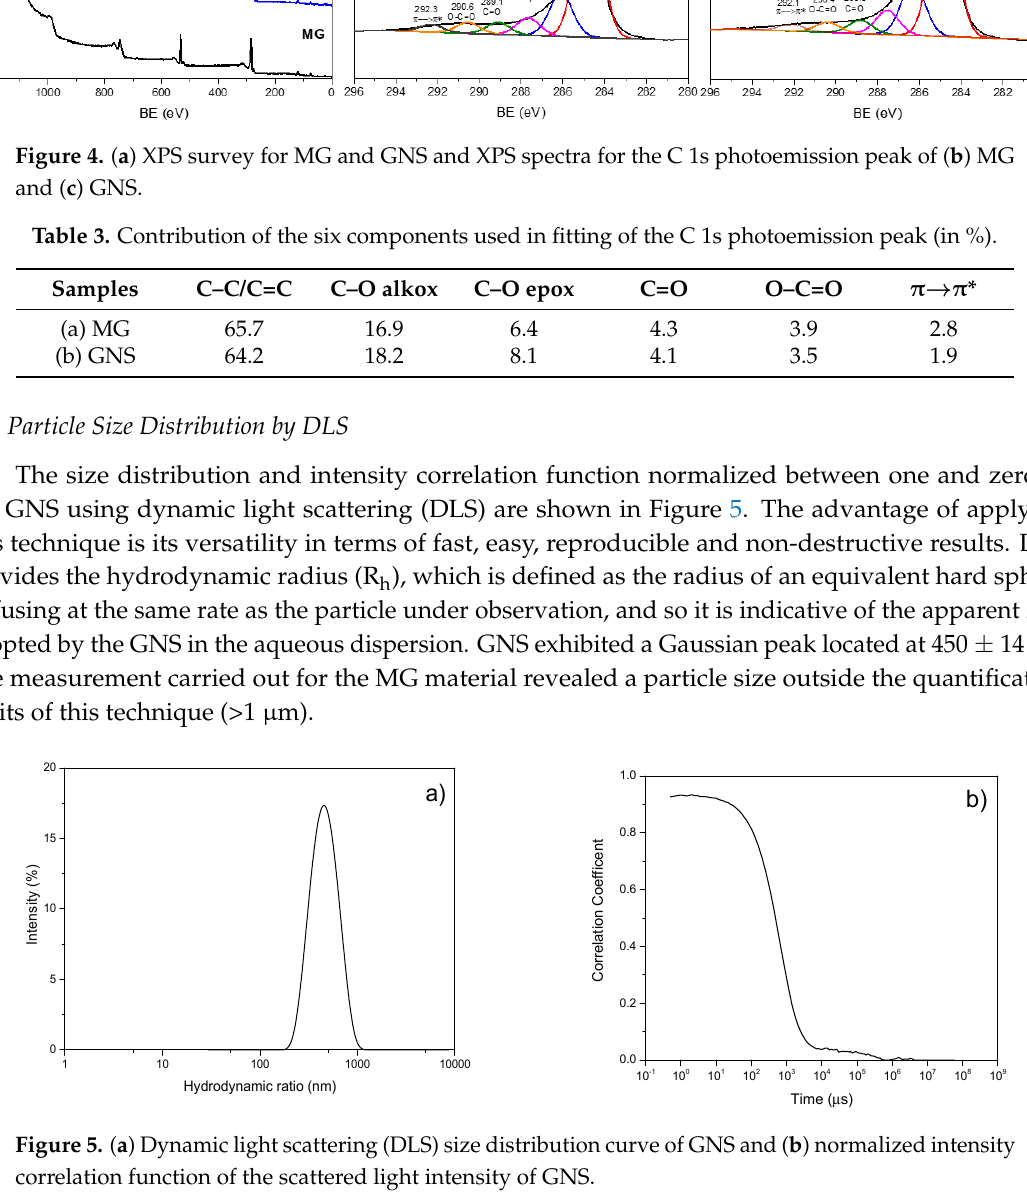
Figure 5. (a ) Dynamic light scattering (DLS) size distribution curve of GNS and ( b ) normalized intensity correlation function of the scattered light intensity of GNS.